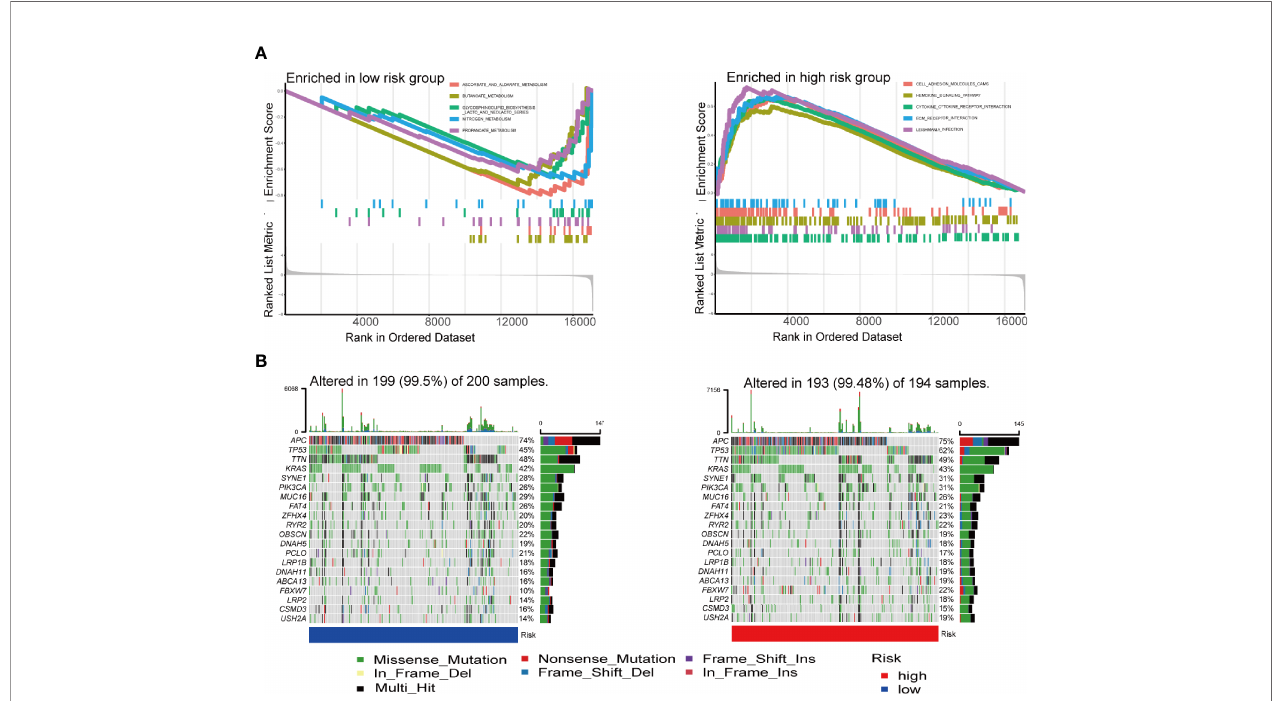
FIGURE 5 | GSEA analysis and mutation analysis of IRGPI groups. (A) Set of genes enriched in IRGPI groups ( P < 0.05). (B) Signi fi cantly mutated genes in the colon cancer samples of different IRGPI groups. Mutated genes are sorted by mutation rate; the arrangement of samples (columns) emphasizes the mutual exclusivity between mutations. Mutation rates are shown on the right, and the total number of mutations is shown above. Color coding indicates mutation type. GSEA, genomic-based gene set enrichment analysis; IRGPI, immune-related gene prognostic